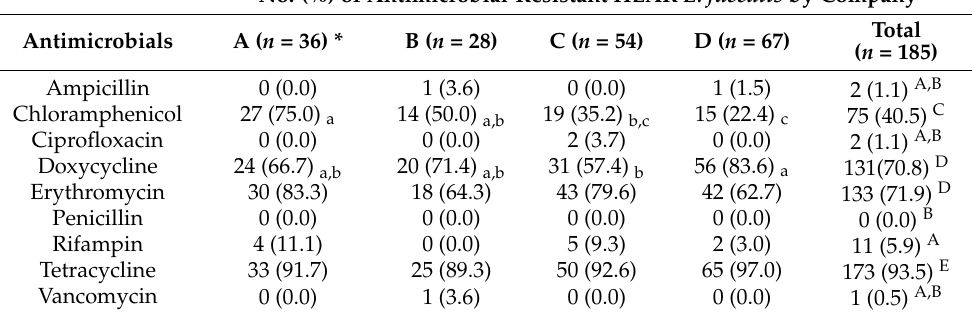
Table 3. Antimicrobial resistance of 185 high-level aminoglycoside-resistant Enterococcus faecalis isolates from the bulk tank milk of four dairy